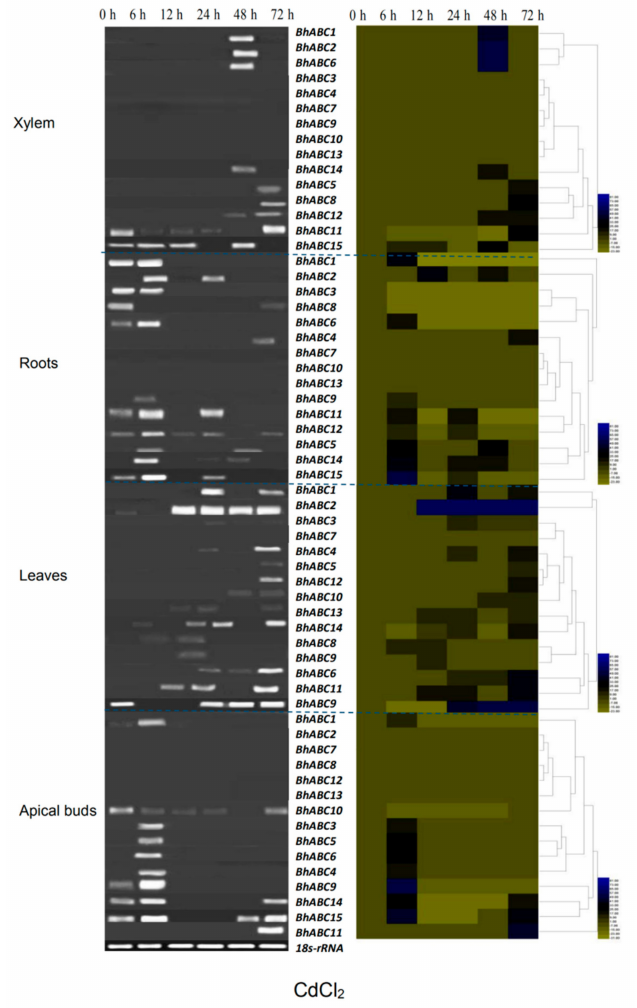
Figure 11. Expression patterns of BhABC genes in xylem, roots, leaves, and apical buds after CdCl 2 treatment. Heat map showing responses of BhABC genes to CdCl 2 (right); semi-quantitative RT-PCR analysis with 18s RNA internal reference